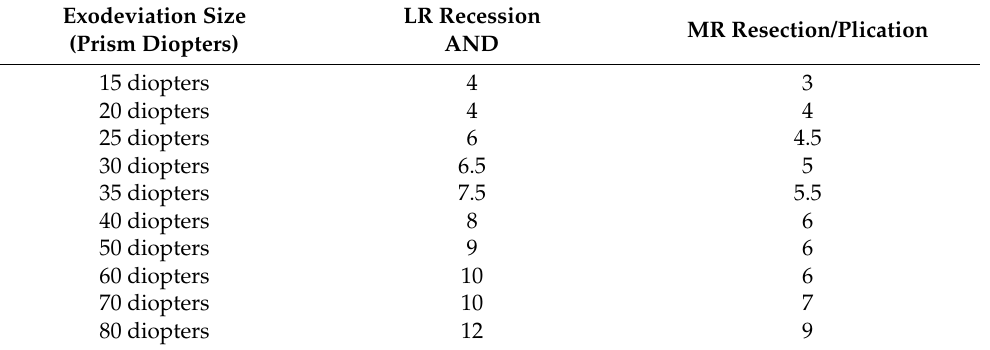
Table 1. Surgical table for asymmetrical two muscle surgery.